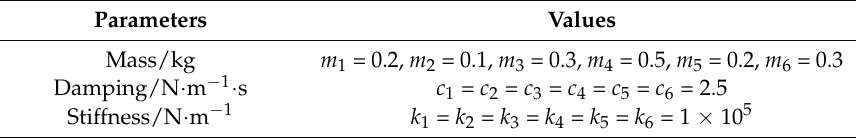
Figure 3. Schematic diagram of a 6-DOF mechanical system. Table 1. Parameters of the 6-DOF